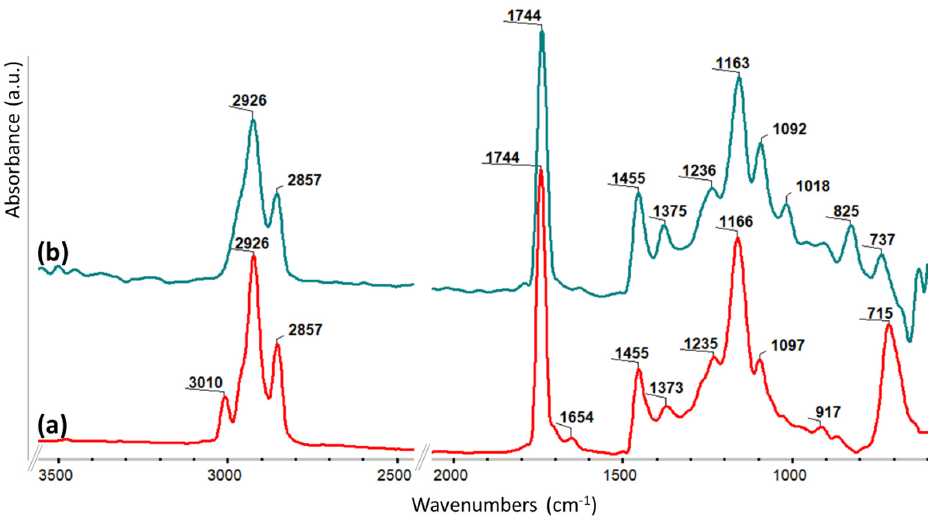
Figure 3. FTIR spectra registered for ( a ) LALO and ( b ) ELALO.